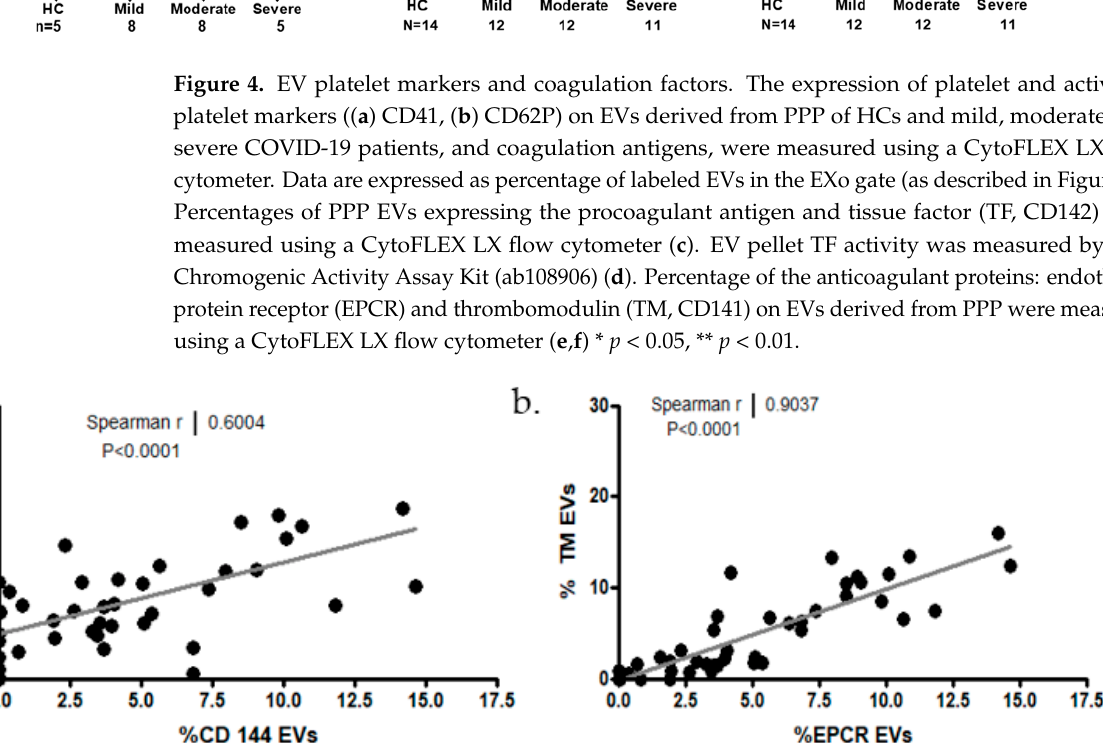
Figure 5. Correlations between expression of EPCR and CD144 ( a ), and between the expression of EPCR and TM ( b ).